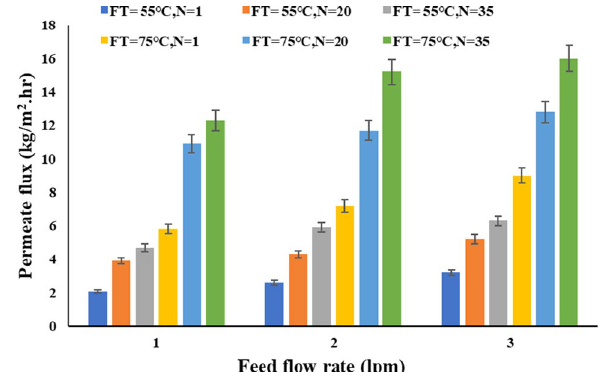
Fig. 9 Effect of FT on permeate flux ( W = 3 mm, L = 270 mm, CFR = 2 lpm)